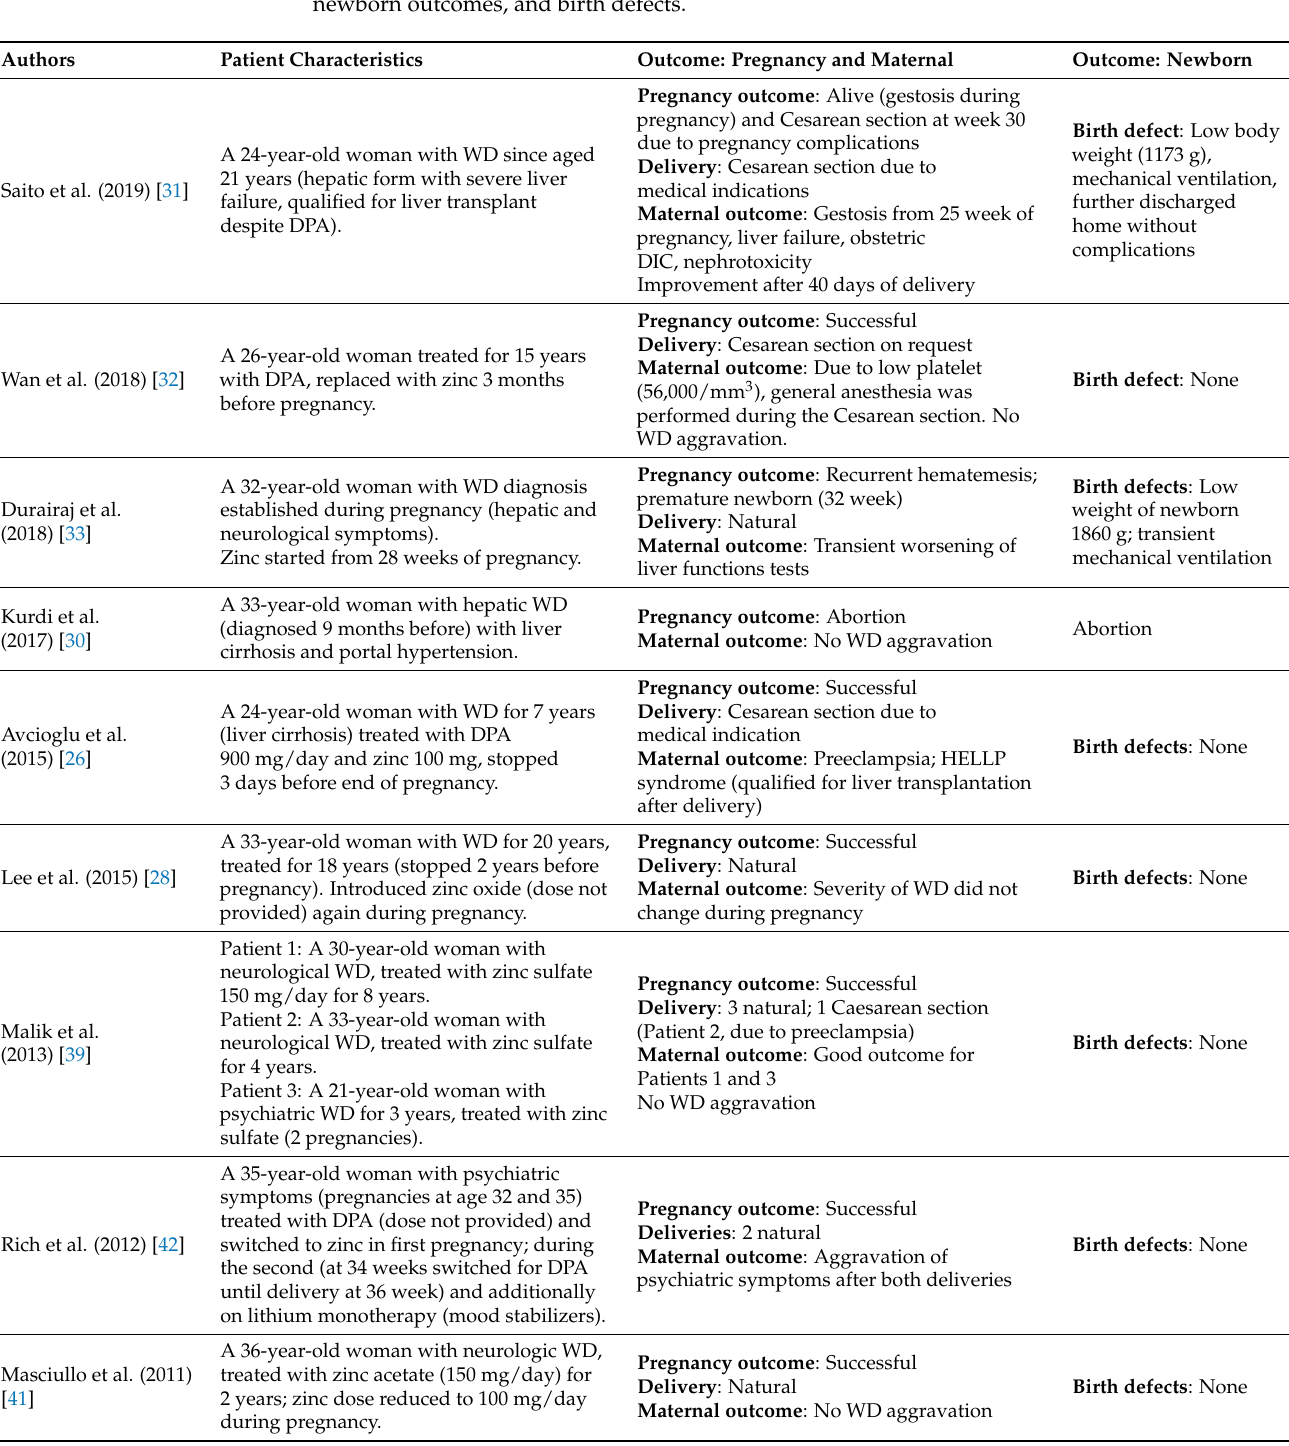
Table 2. Summary of case and series reports of pregnant patients with Wilson’s disease according to the time of diagnosis, anti-copper treatment, pregnancy and delivery complications, maternal and newborn outcomes, and birth